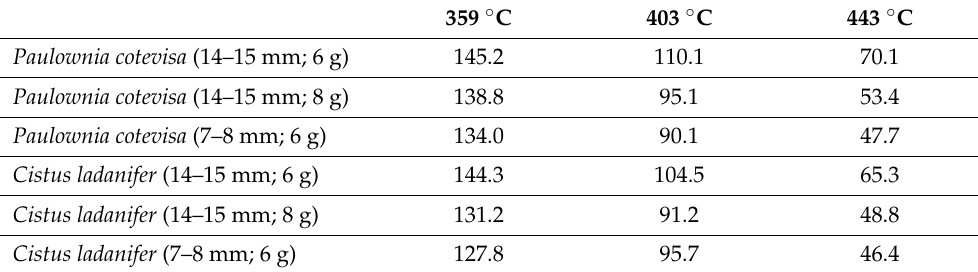
Table 6. Ignition time of Paulownia cotevisa and Cistus ladanifer pellets (s).